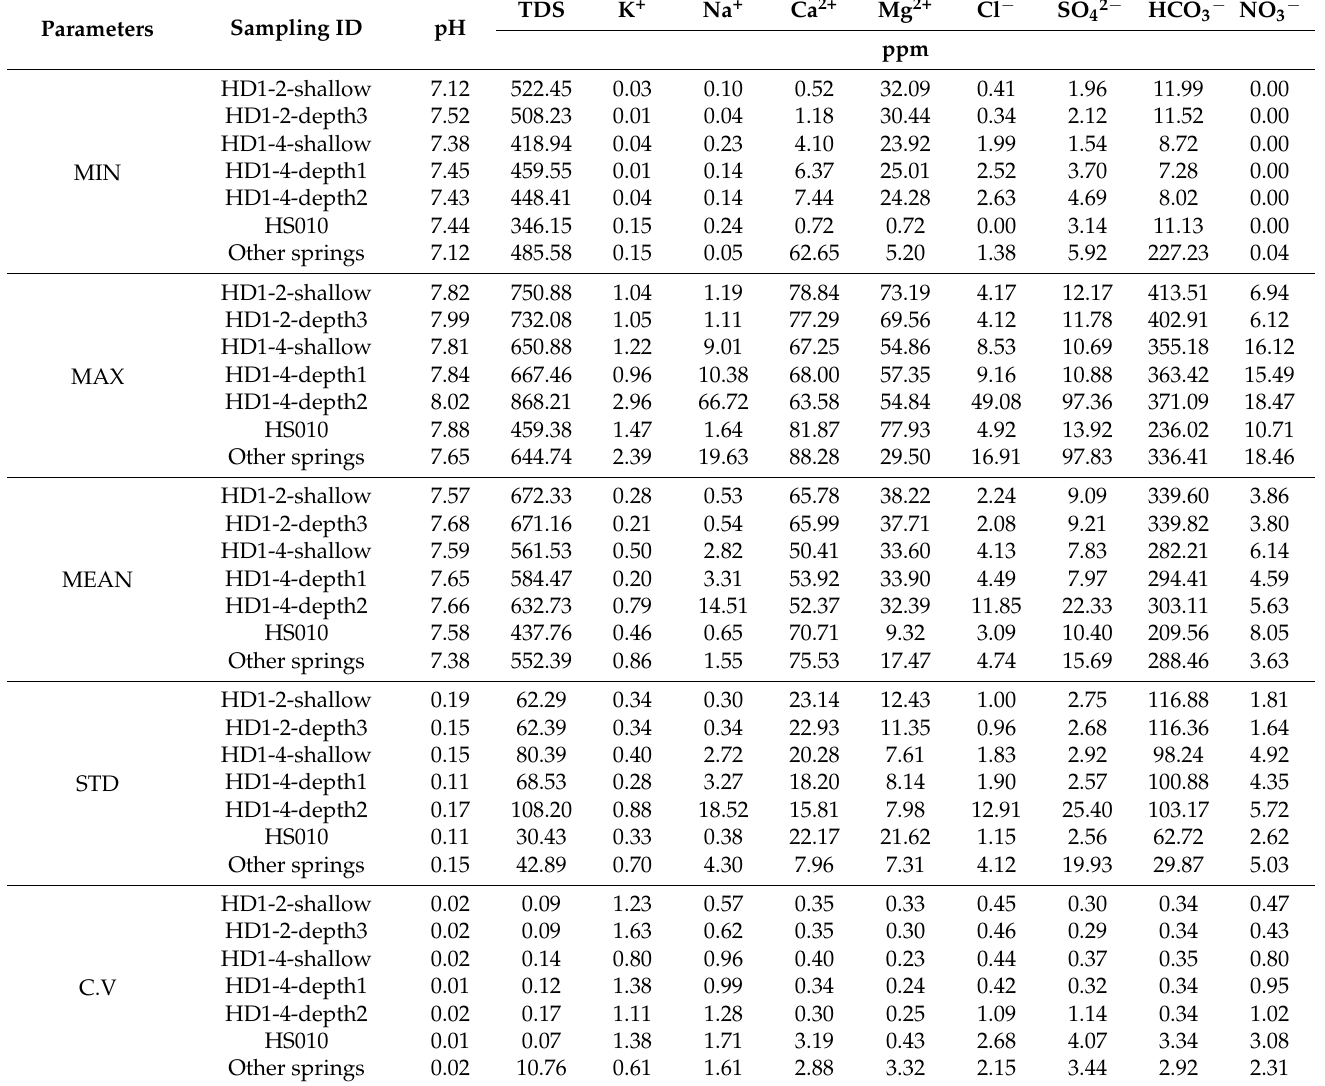
Table 2. Parameter statistics for major